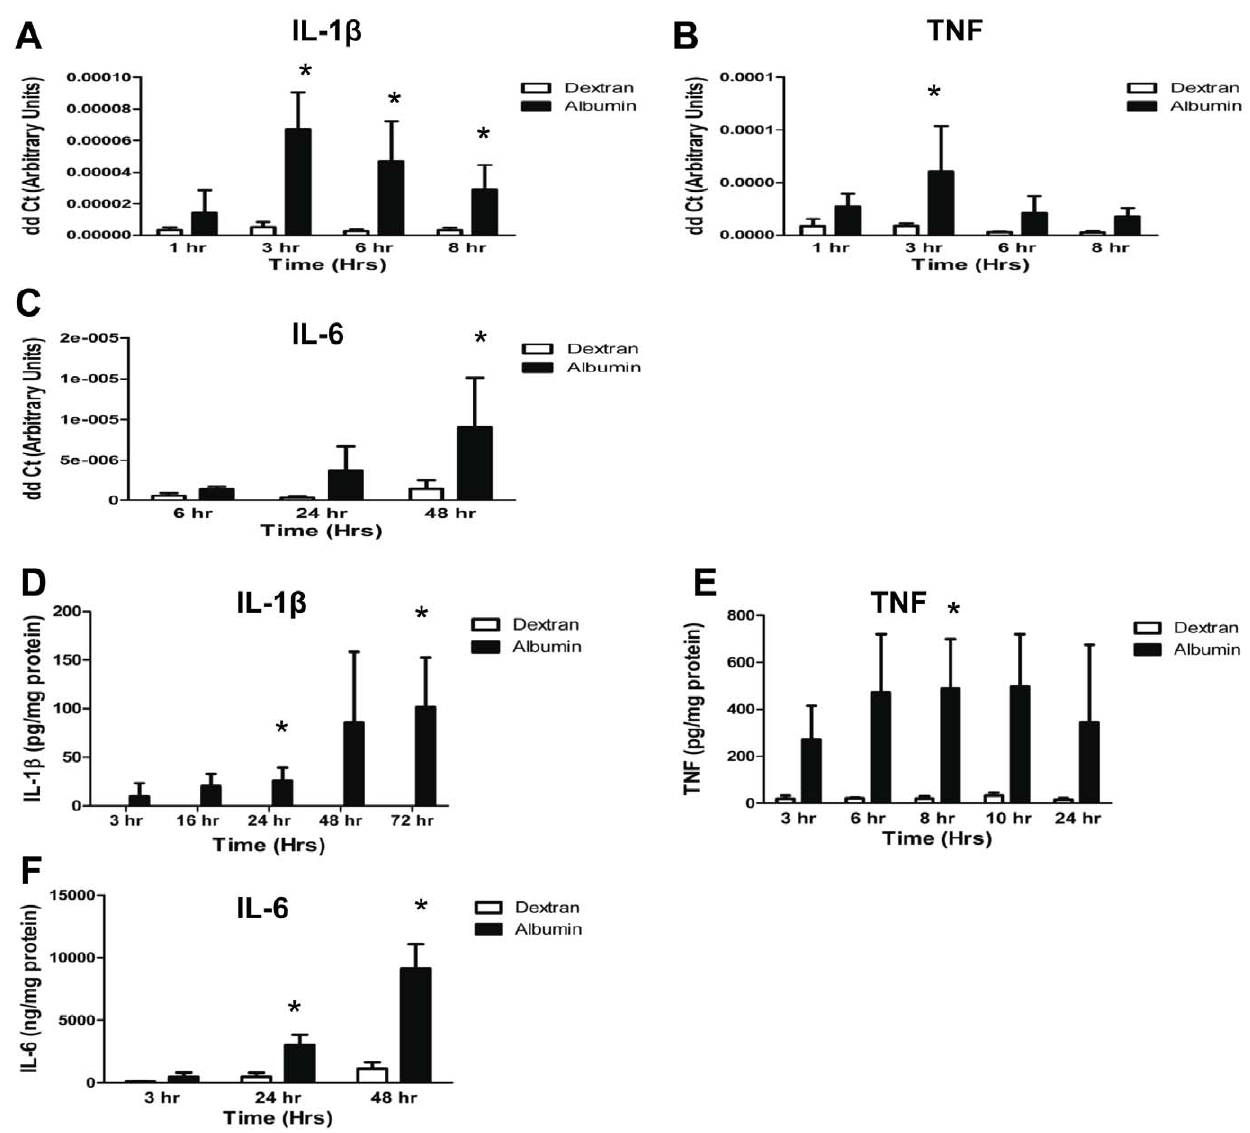
Figure 4. Albumin exposure modulates pro-inflammatory cytokine expression and release in human podocytes. A , Time course of IL- 1 b RNA levels in podocytes treated with 5 mg/ml recombinant low endotoxin human albumin (closed bars) or 5 mg/ml dextran (open bars). * denotes P=0.0002 compared to dextran controls. B , Time course of TNF RNA expression in podocytes treated with 5 mg/ml human albumin (closed bars) or 5 mg/ml dextran (open bars). * denotes P=0.01 compared to dextran control. C , IL-6 RNA levels in podocytes treated with 5 mg/ml human albumin (closed bars) or 5 mg/ml dextran (open bars). * denotes P=0.008 compared to dextran control. D, Amount of IL-1 b normalized to total cellular protein released into the medium after treatment of podocytes with 5 mg/ml recombinant human albumin (closed bars) or 5 mg/ml dextran (open bars) for varying amounts of time. * denotes P=0.005 compared to dextran treated controls. E , Amount of TNF normalized to total cellular protein released into the medium by podocytes after treatment with albumin (closed bars) or dextran (open bars) for varying amounts of time. * denotes P=0.003 compared to dextran treated control cells. F , Levels of IL-6 normalized to total cellular protein released into the medium by podocytes treated with albumin (closed bars) or dextran (open bars) for varying amounts of time. * denotes P , 0.0001 compared to dextran treated controls. matory response. As shown in Figure 4A, podocytes treated with albumin had a significant increase in IL-1 b RNA levels (P =0.0002 versus dextran; Fig. 4A) compared to dextran treated controls. Albumin also significantly up-regulated TNF RNA expression at 3 hrs compared to dextran treated cells (P= 0.01 versus dextran; Fig. 4B). After 48 hrs of albumin treatment IL-6 RNA levels were also significantly increased (P= 0.008 versus dextran, Fig. 4A).